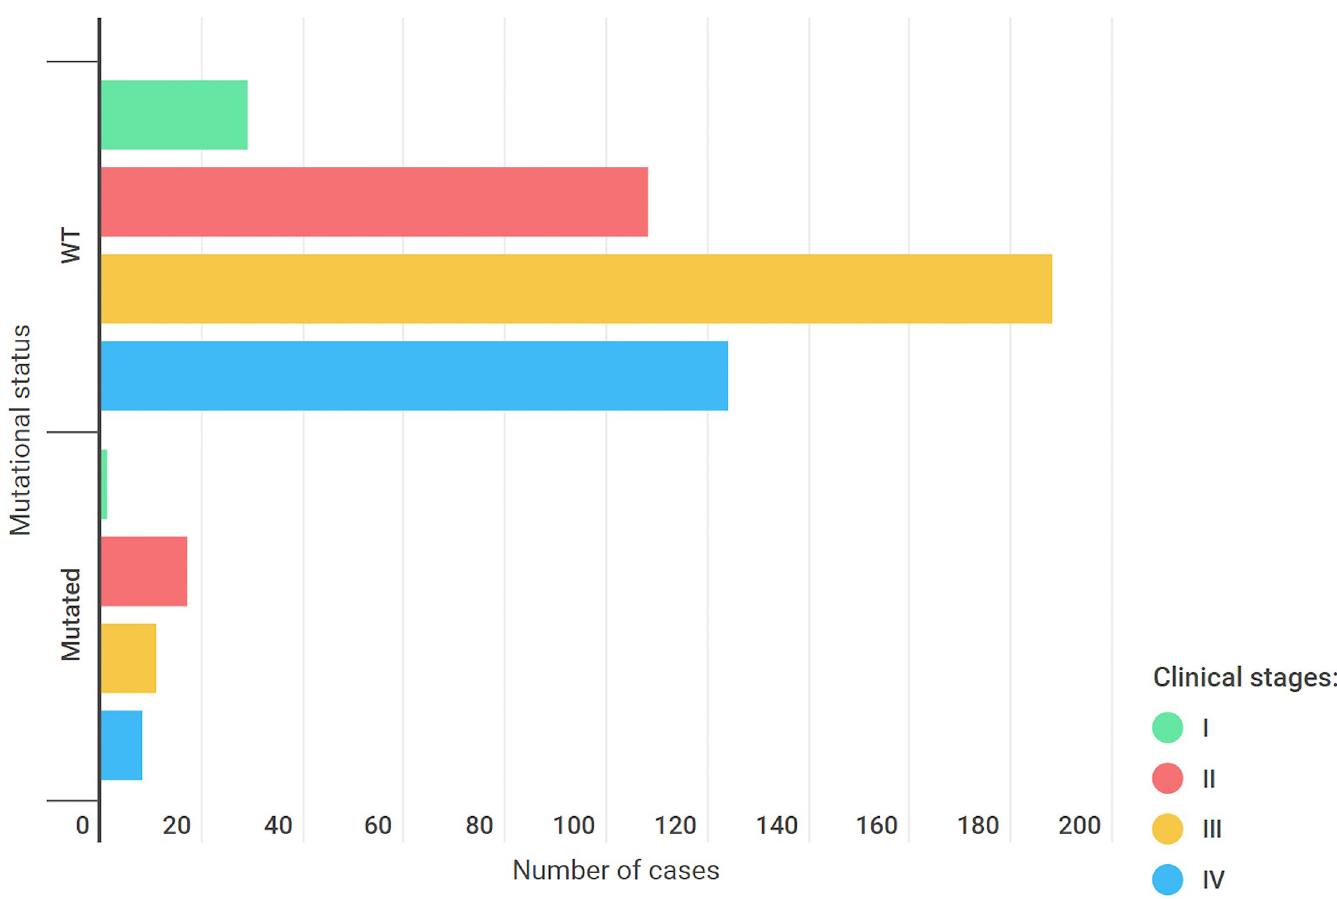
Fig 3. Clinical stages among wild-type and mutated cases.